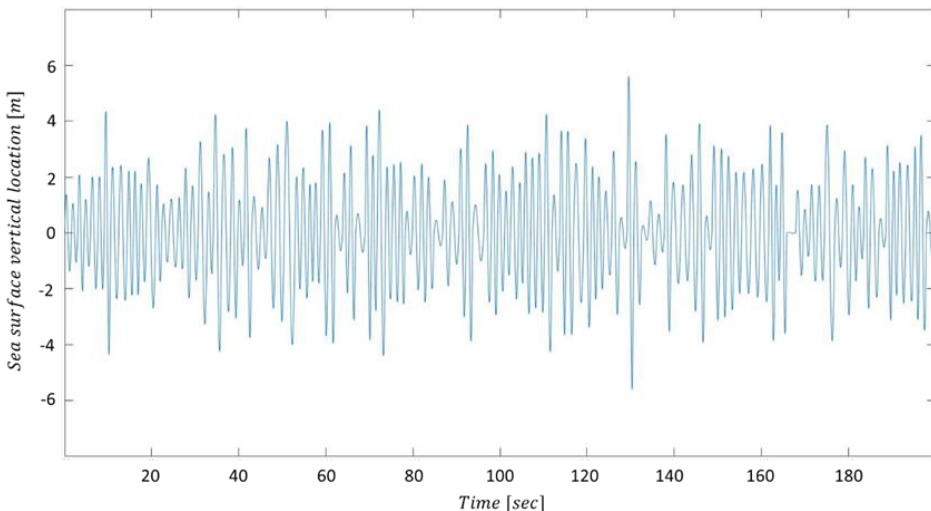
Figure 6. Time-series of surface elevation of the randomized waves.